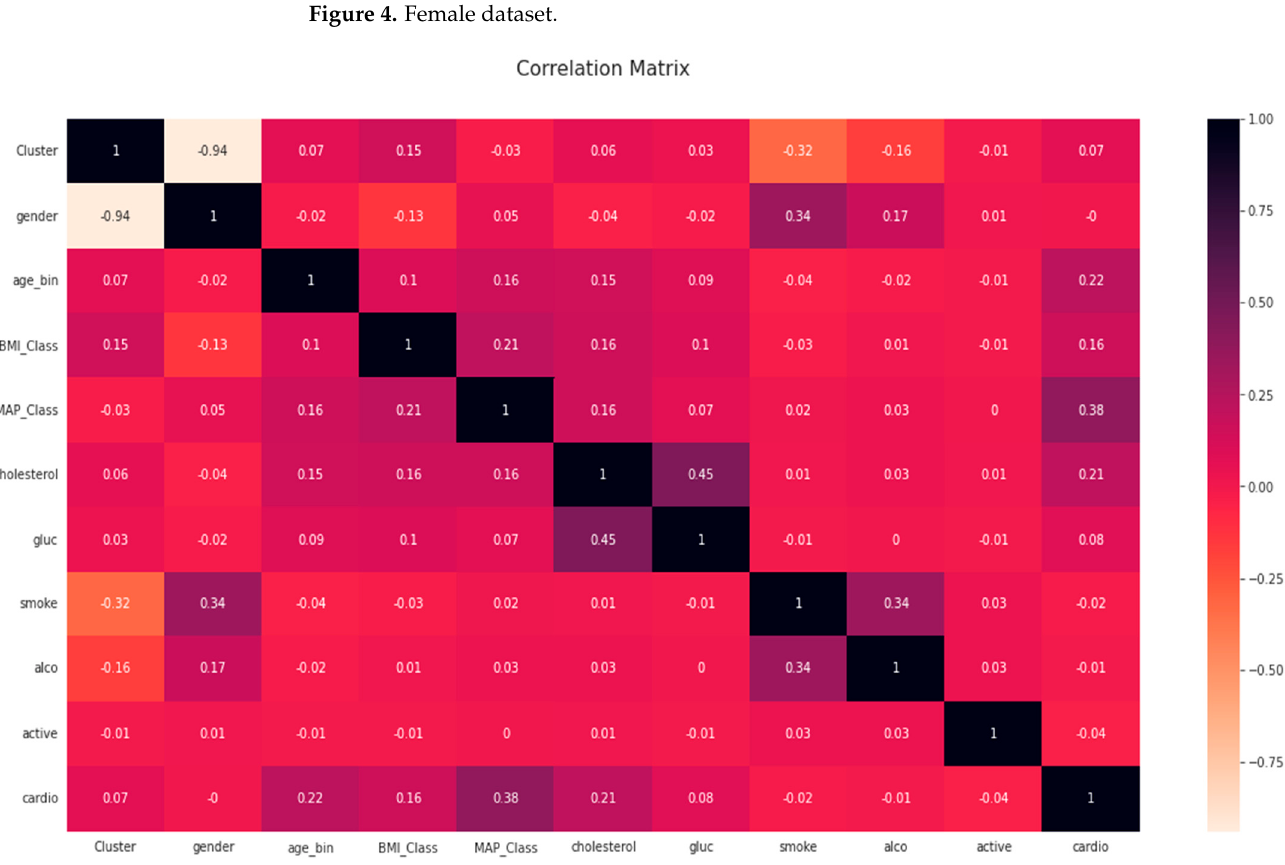
Figure 5. Correlation heatmap.